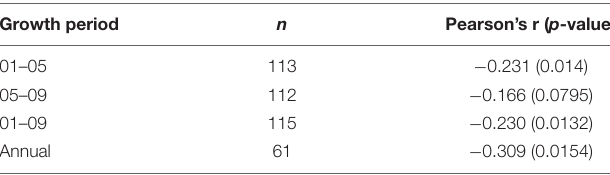
TABLE 4 | Pearson correlations between defoliation and growth.